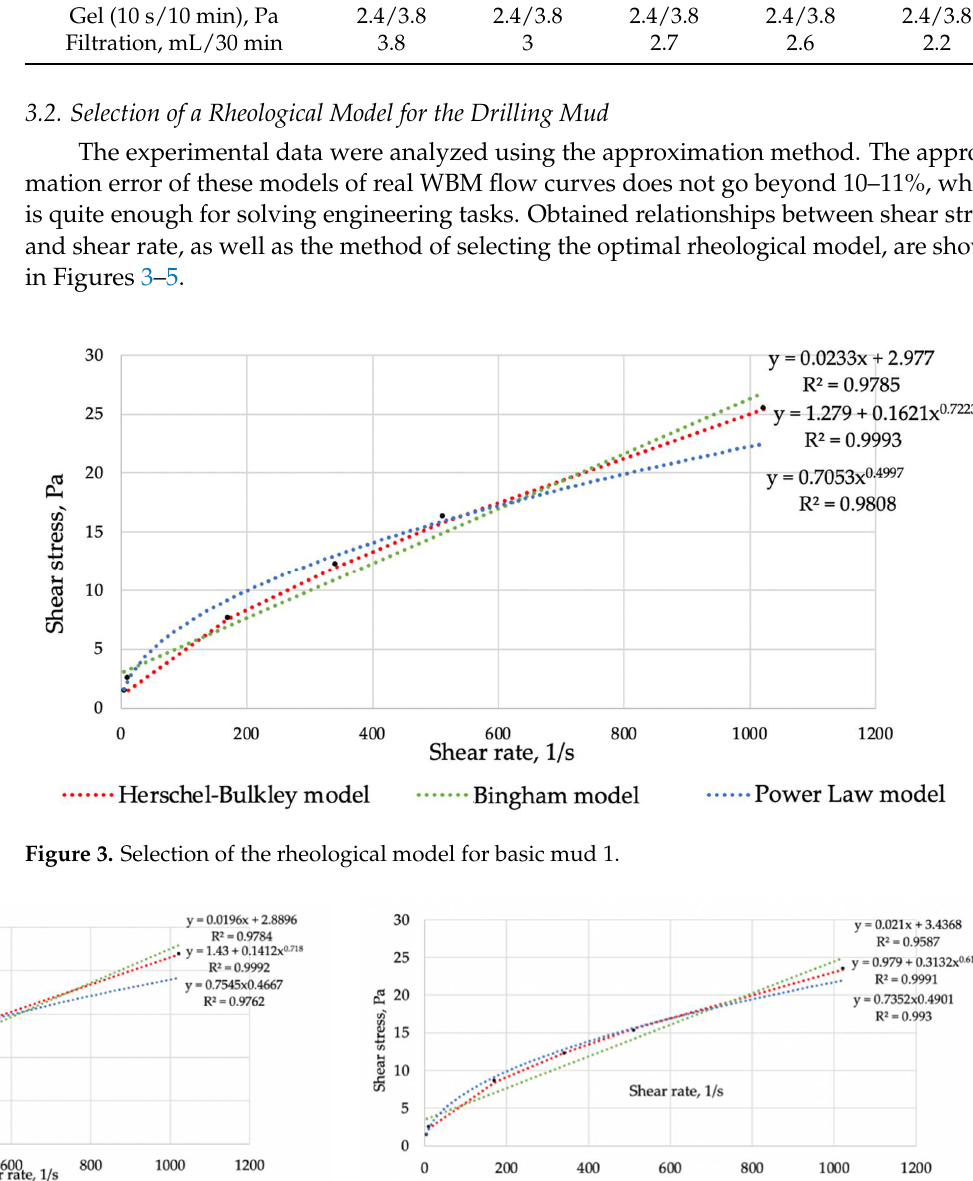
( b ) Figure 5. Selection of the rheological model for sample 4 with PHPA MM = 20 million ( a ) and for sample 5 with PHPA MM = 27 million ( b ).